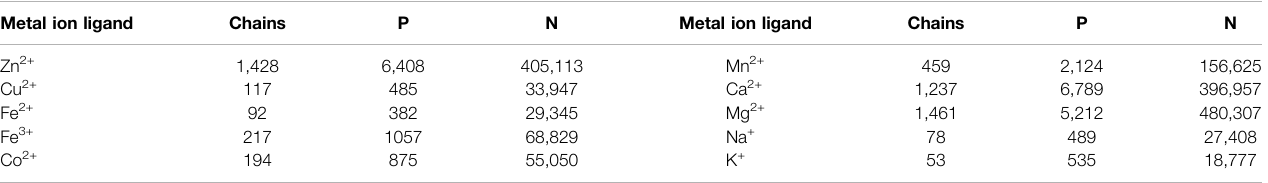
TABLE 1 | The benchmark datasets of ten metal ion ligands.